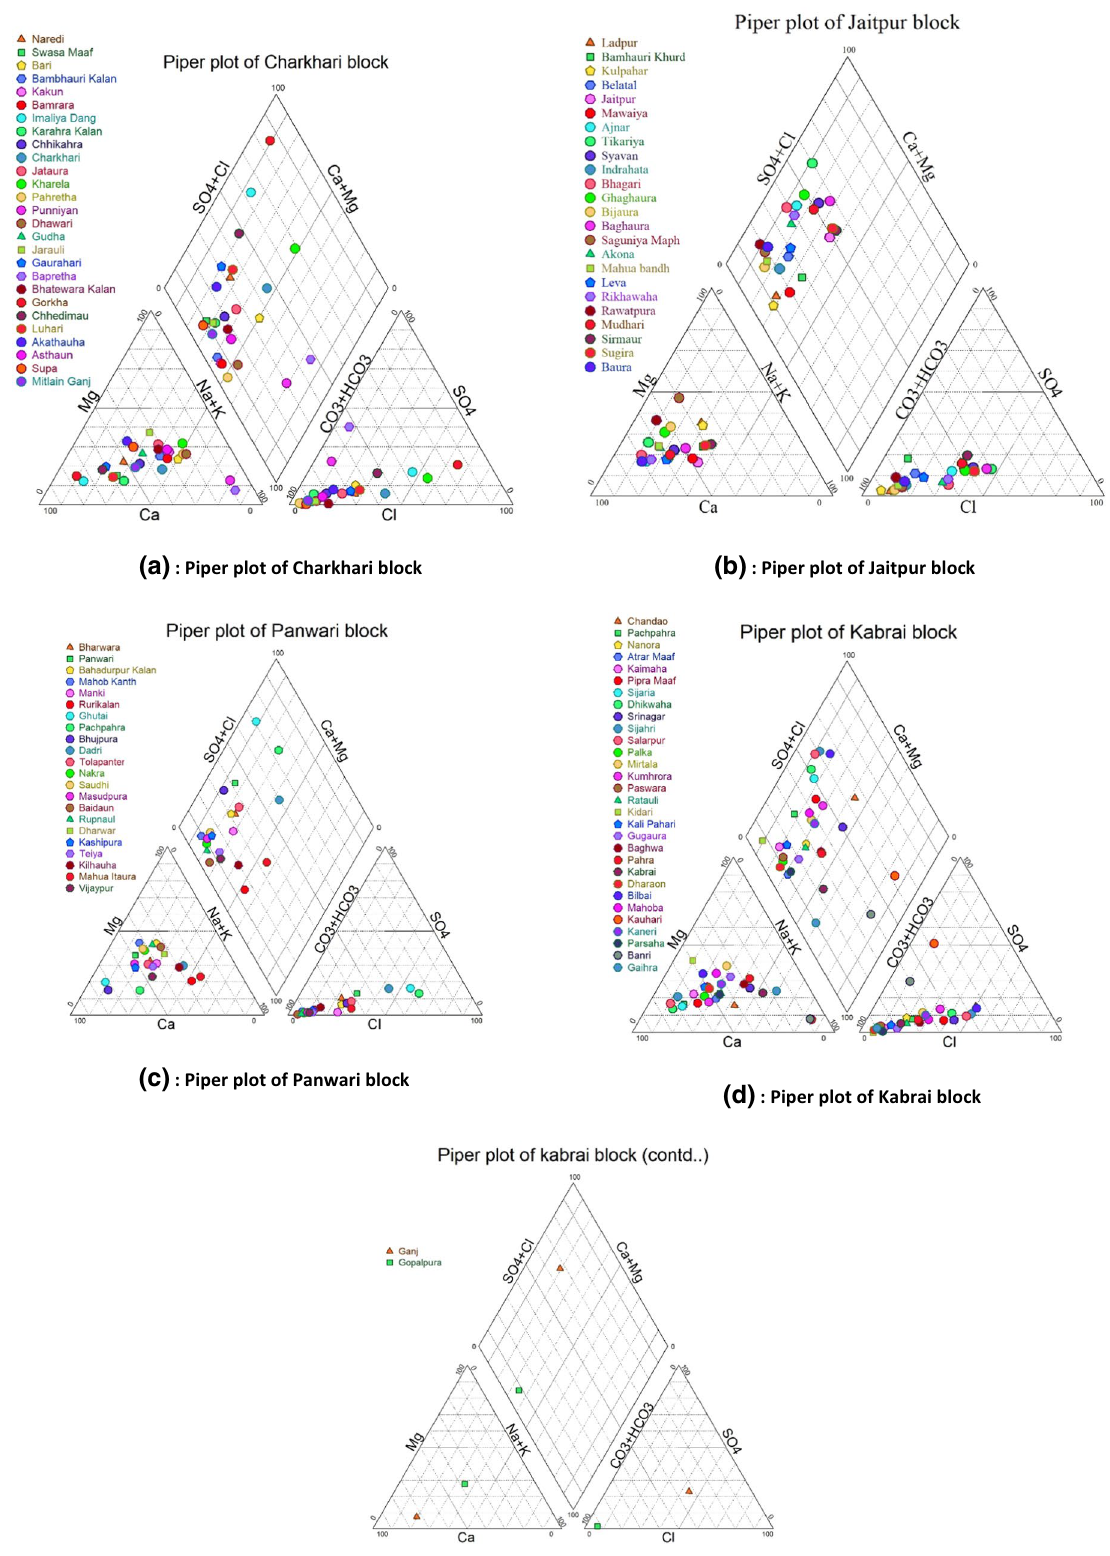
(e) : Piper plot of Kabrai